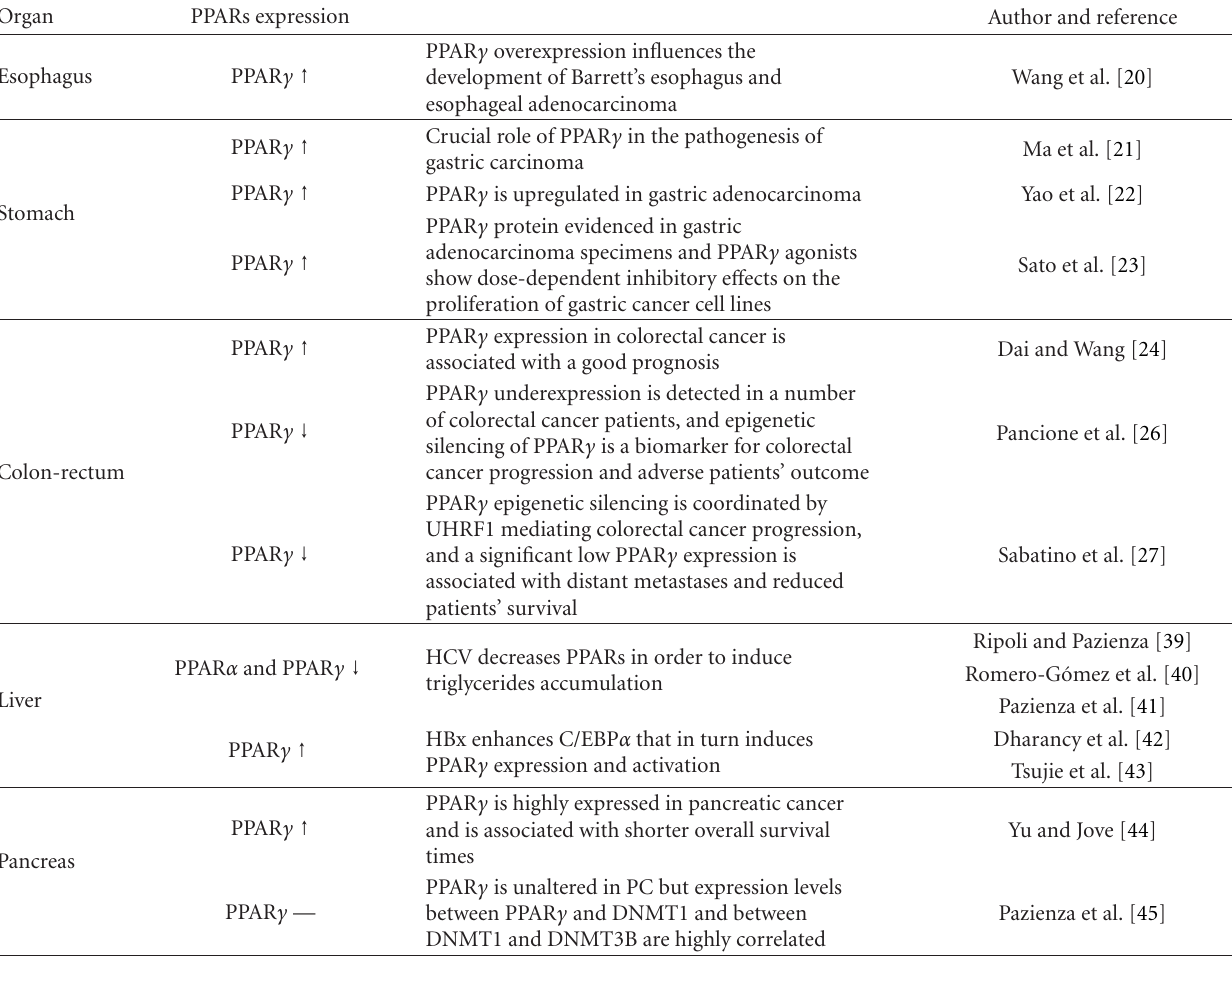
Table 1: Di ff erential patterns of PPARs expression in gastrointestinal system disease.